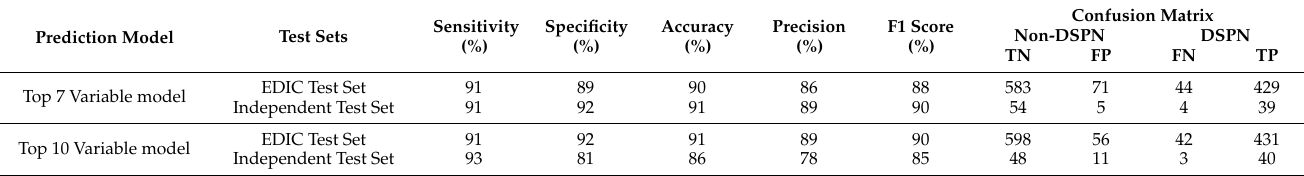
Table 5. Evaluation of the performance for the top 7 and 10 features using a logistic regression model to construct the nomogram for DSPN prediction.